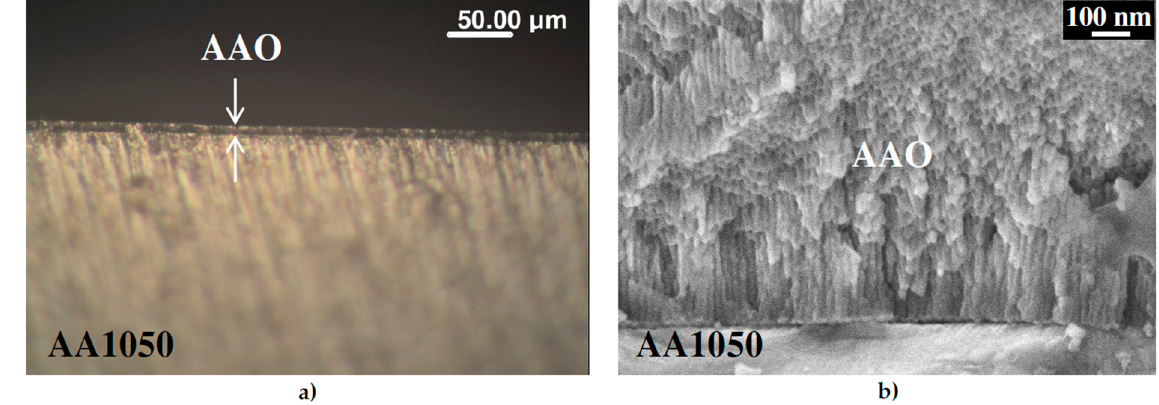
Figure 6. Optical micrograph ( a ) and scanning electron micrograph ( b ) of the thickness of the AAO film synthesized in two anodization steps in 2 M sulphuric acid at 10 °C and 10 V for 1 h.